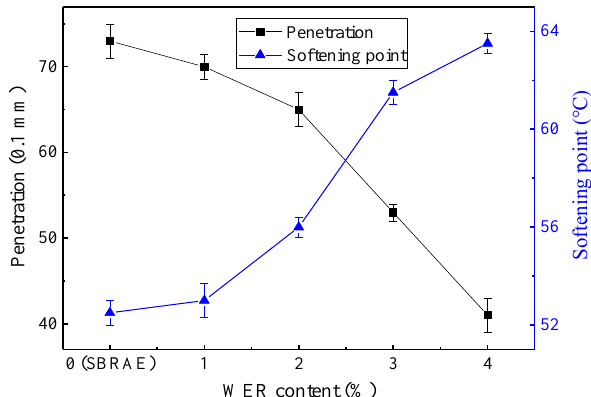
Figure 4. Penetration and softening points of evaporation residues for WESAE and SBRAE.